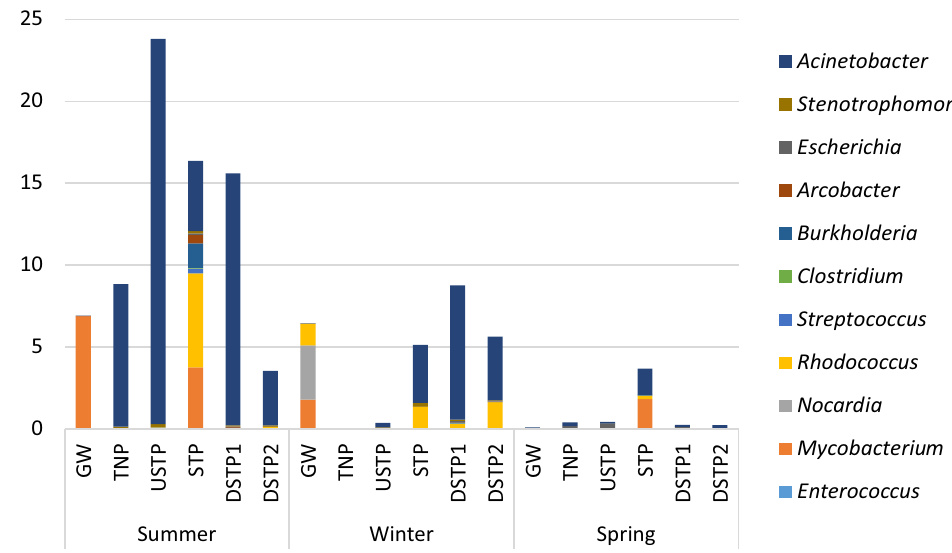
Figure 5. Bacterial genera with potentially pathogenic species, the relative abundance of which in the studied sites exceeded 0.01% Site abbreviations are as follows: GW—groundwater; TNP—Tatra National Park;